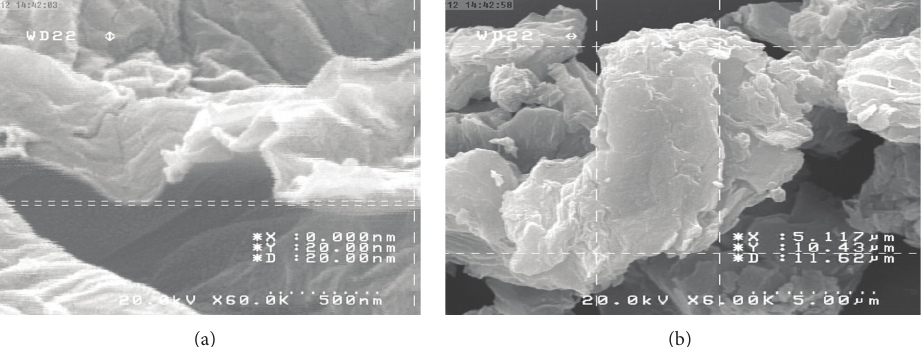
Figure 1: FE-SEM image of aggregated graphene oxide flakes (a). FE-SEM image of graphene oxide flakes with film thickness of about 20nm (b).